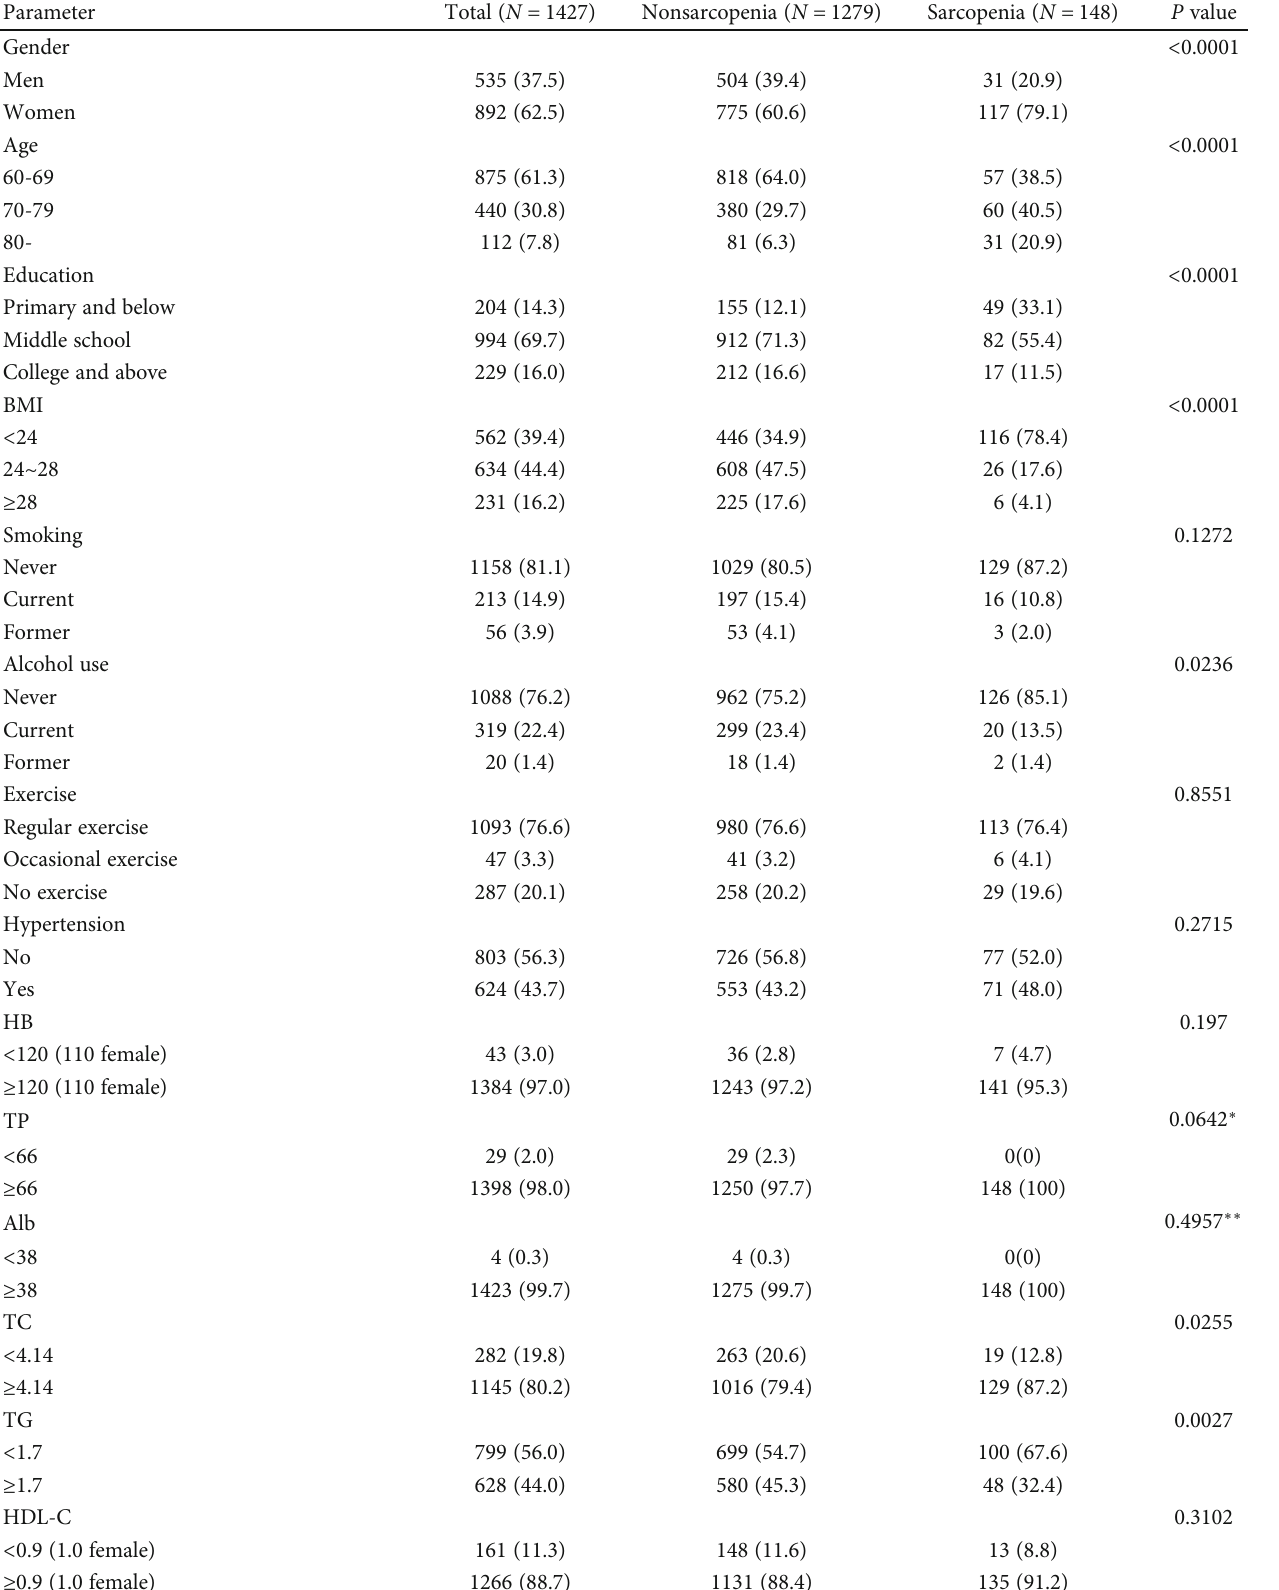
Table 1: Univariate analysis of baseline characteristics in elderly sarcopenia vs. nonsarcopenia